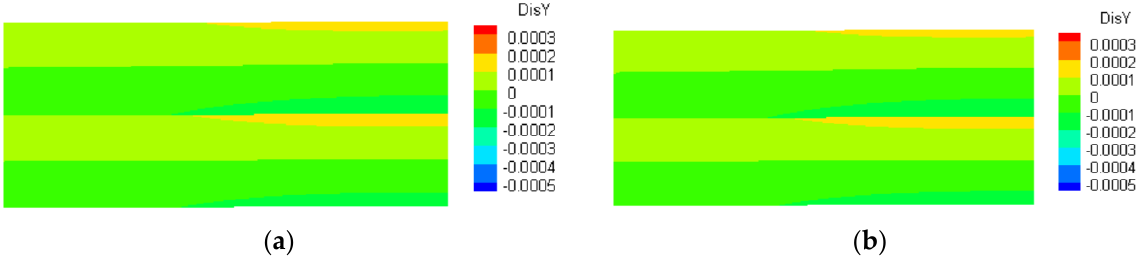
Figure 6. The distribution of displacement in X-direction. ( a ) SBFEM. ( b ) ANSYS.